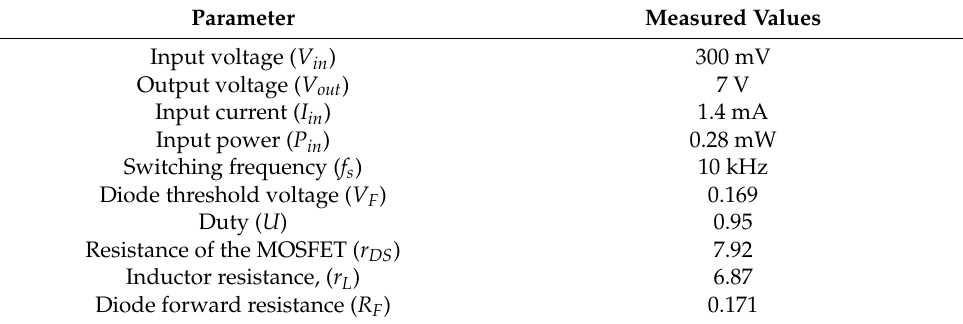
Table 7. Estimated and measured parameter values of the